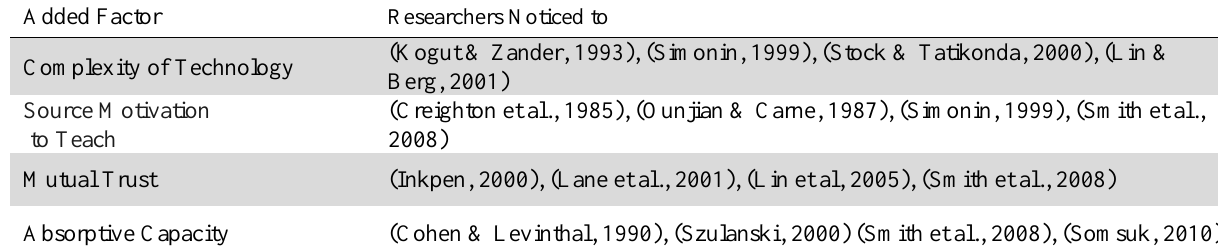
Added factors based on literature